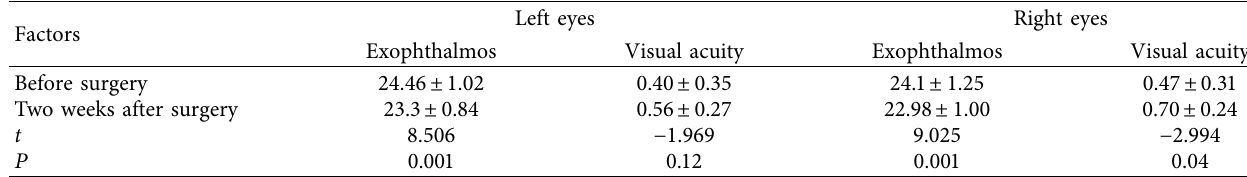
Table 2: Comparison of ocular symptoms and visual function before and after surgery in patients with Graves